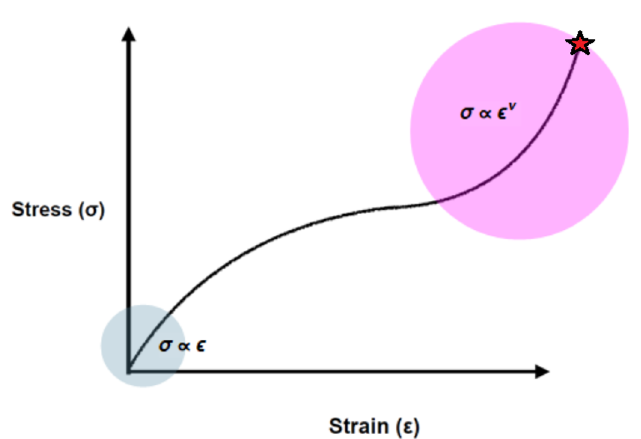
Figure 1 . Cartoon of a typical stress-strain curve of a hyper-elastic material [6]. In light blue shade the linear regime, in which stress / strain. At large strain deformation, the stress-strain relation can display a power law behaviour, (cid:27) / (cid:15) (cid:23) , with some exponent (cid:23) . The light red area illustrates this behaviour with (cid:23) > 1. Materials typically break or fracture after some critical deformation, which translates in the stress-train curves terminating at some point. The red star indicates the breaking